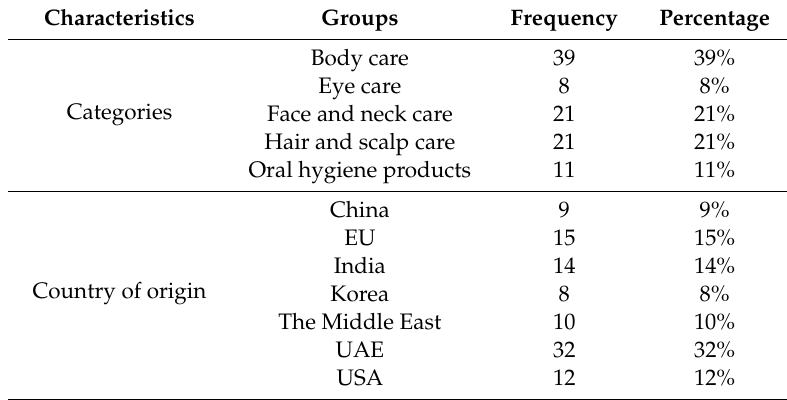
Table 1. Number and percentage of cosmetics and personal care product characteristics ( n = 100). Characteristics Groups Frequency Percentage Body Categories